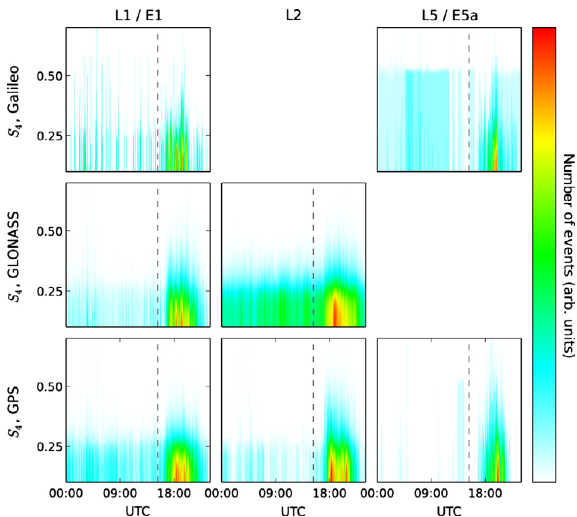
Figure 5. Aggregated statistics of scintillation occurrence in 2013 for the different signals as function of sunset corrected time. The dashed vertical lines indicate the time of sunset.